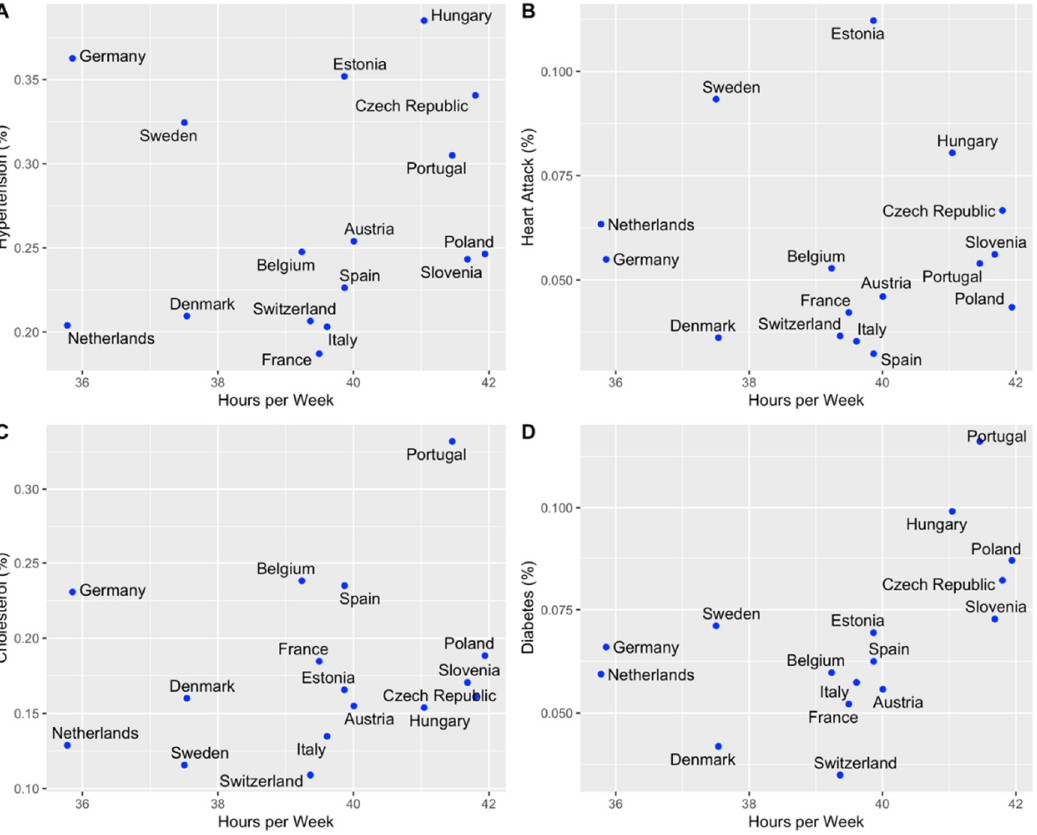
Figure 2. Association of reported health conditions and working hours by country. ( A ) represents the prevalence of hypertension in included countries by working hours per week. ( B ) represents the prevalence of heart attack in included countries by working hours per week. ( C ) represents the prevalence of cholesterol in included countries by working hours per week. ( D ) represents the prevalence of diabetes in included countries by working hours per week.